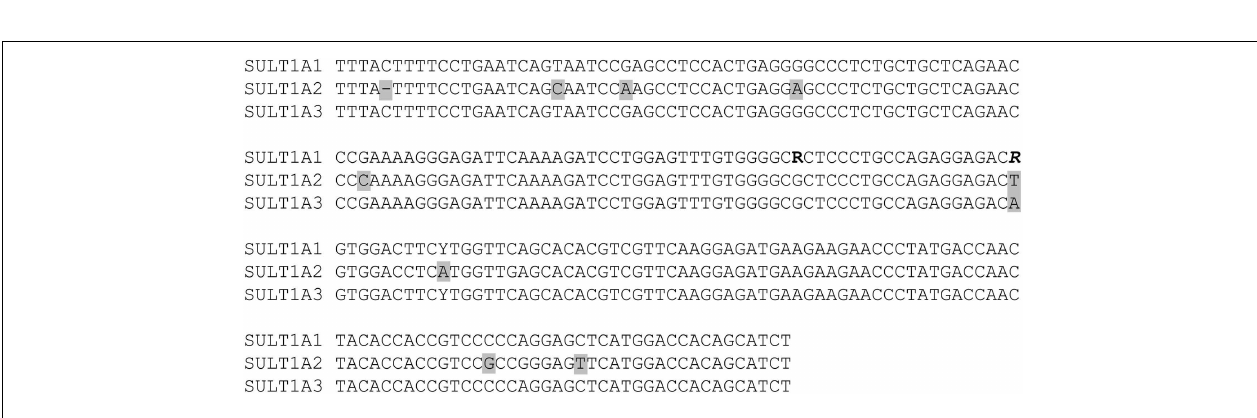
base pairs upstream and downstream from these loci. Comparison of the DNA sequences shows that these genes differ only in a small of number of nucleotides (marked in gray) indicating sequence similarities of more than 90% between SULT1A1 , SULT1A2 , and SULT1A3 .